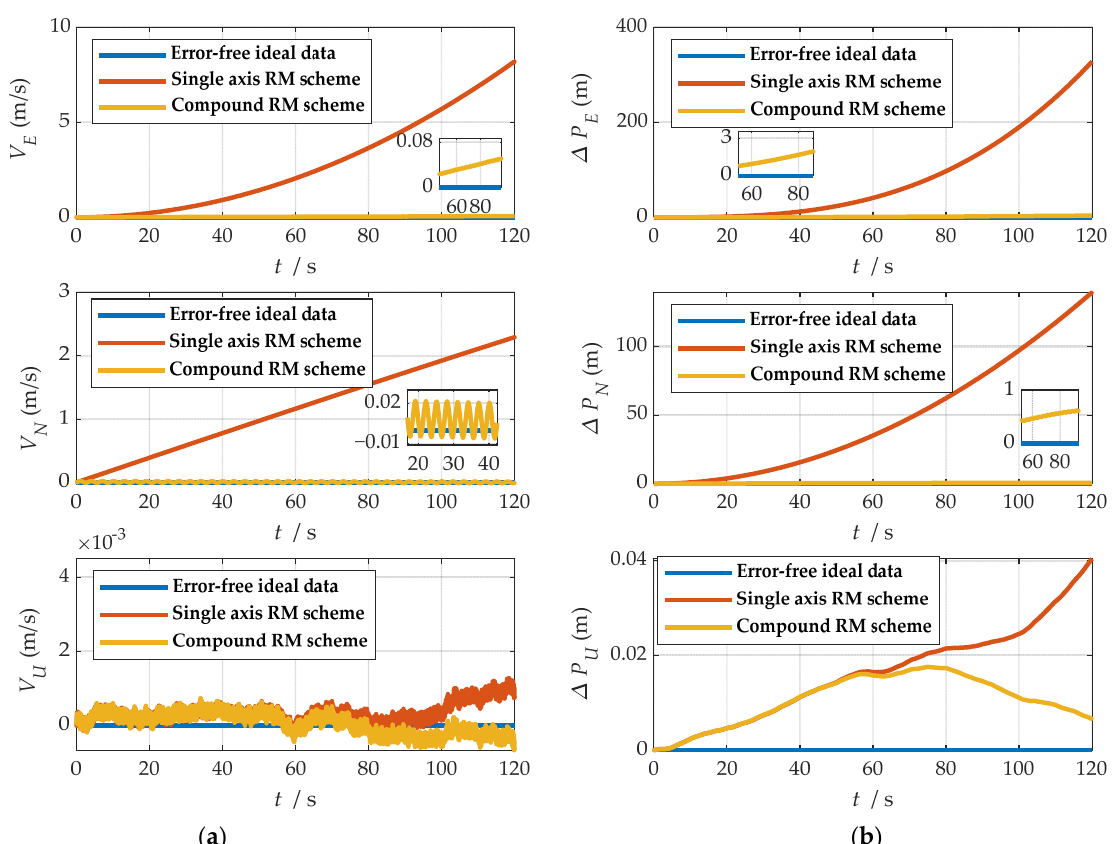
Figure 21. Comparison of velocity and position results in three directions: ( a ) comparison of velocity results in three directions; ( b ) comparison of position results in three directions. Table 7. Maximum errors between two rotational modulation schemes’